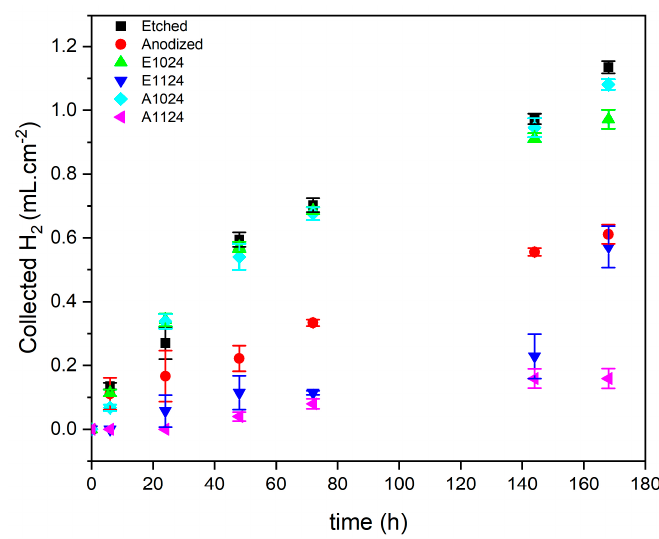
Figure 10. Results of collected H 2 after 7 days immersion in 0.1 M NaCl solution.